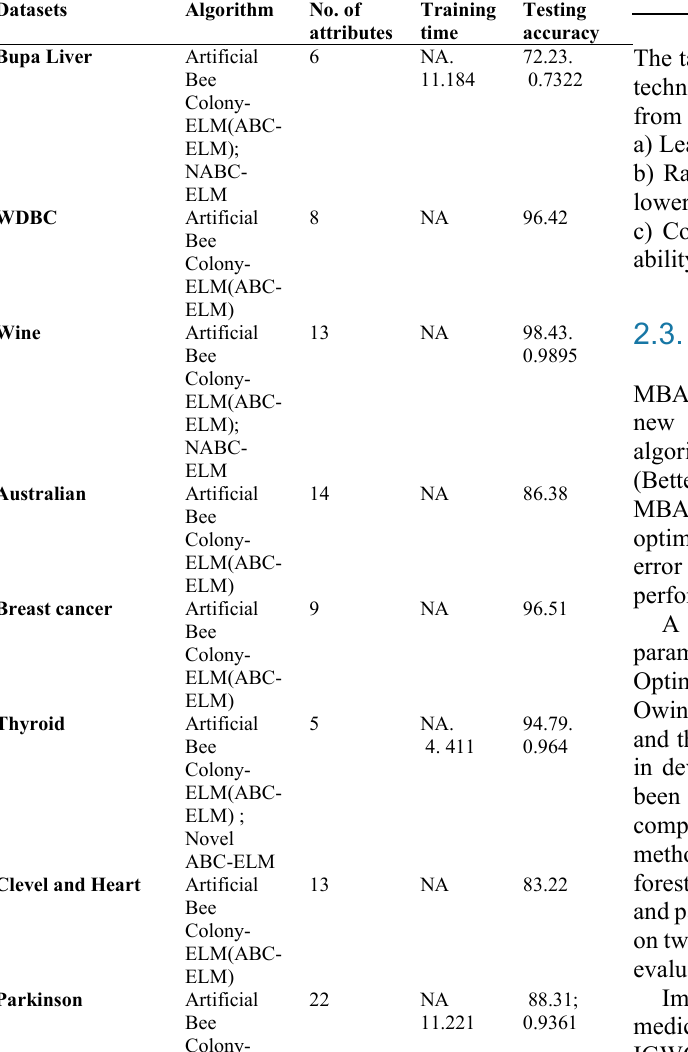
Table 4. Algorithm accuracy of the suggested techniques in the aspect of datasets [42-46]